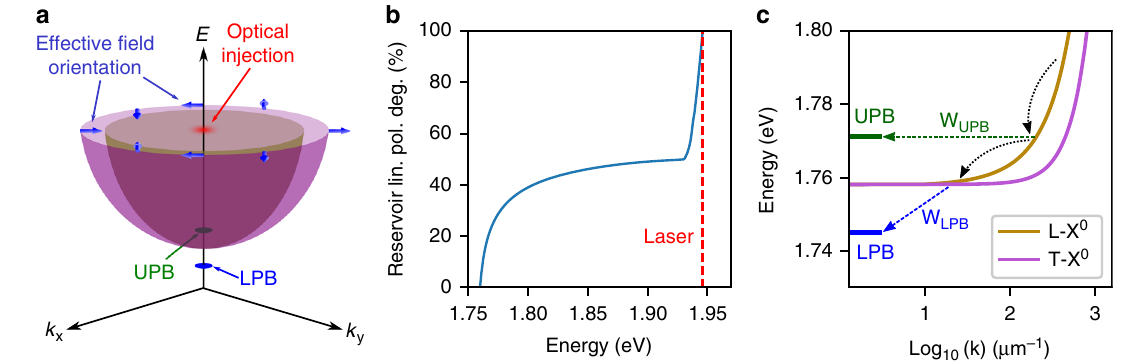
Fig. 4 Theoretical model for relaxation of valley coherent excitons and polaritons. a Dispersion of polariton and longitudinal-transverse (LT) split exciton states at zero exciton-photon detuning. Carriers are injected at high energy, which form momentum-dark reservoir excitons distributed around the elastic circle. Long range electron-hole exchange interactions lead to a k -dependent energy splitting between exciton states with dipole moment parallel (L, represented by the inner parabola) and perpendicular (T, represented by the outer parabola) to the in-plane wavevector. This gives rise to an effective spin- orbit coupling that may be treated as an in-plane magnetic fi eld, which acts on the exciton valley pseudospin and has an orientation which depends upon the exciton momentum. The upper and lower polariton branches (UPB and LPB) exist at lower energy, and are limited to k ≈ 0, where the exchange interaction is weak, shielding the polariton states from dephasing. b Simulated average linear polarization degree of exciton reservoir states as a function of energy, at zero exciton-photon detuning. The dependence is discussed in the main text. Red dashed line indicates laser energy. c Close-up of the dispersion of polariton and LT-split exciton states, at zero exciton-photon detuning. Dashed and dotted lines indicate relaxation pathways of excitons, with W UPB and W LPB describing the relaxation rates from the reservoir into the polariton